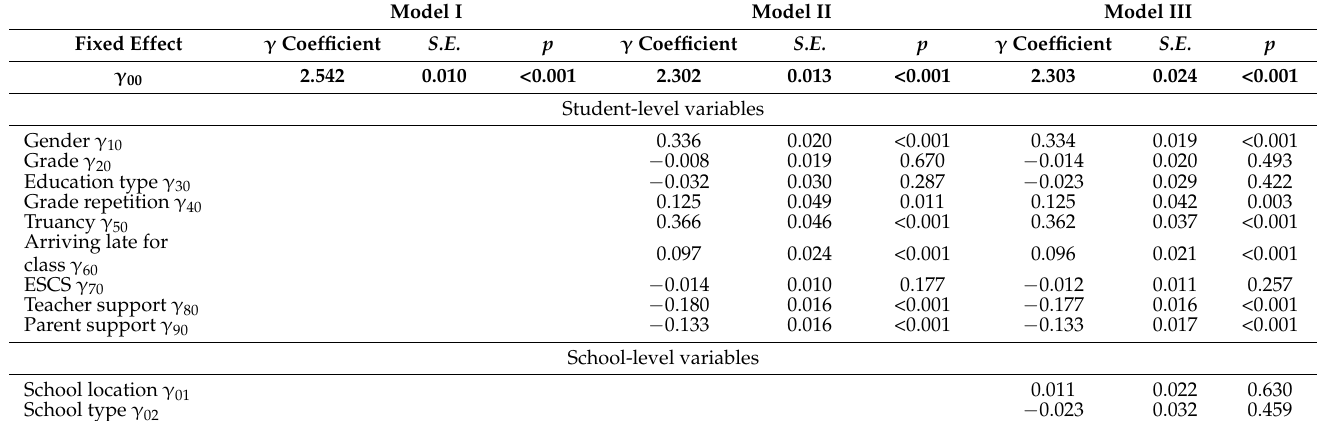
Table A2. Multilevel analysis results of the influencing factors of students suffering from verbal